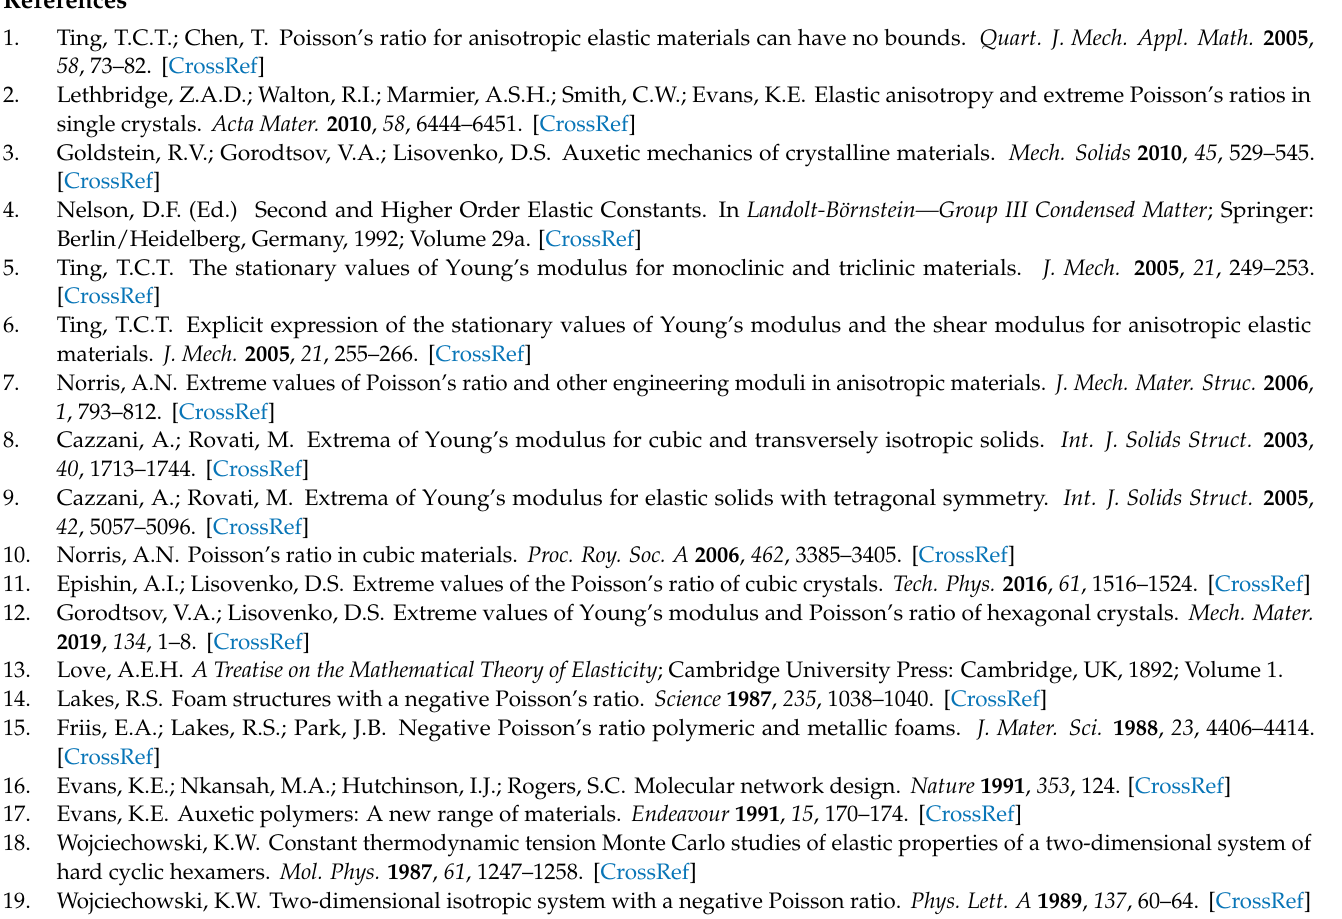
rhombic crystals. Table S2: Values of Young’s modulus, E 1 , E 2 , E 3 , E 4 , E 5 , E 6 and E 7 , for rhombic crystals. Global maximum and minimum values are shown in bold. Angle values are given in degrees. Table S3: The values of the minimum and maximum Young’s moduli E min and E max and their ratios E max / E min ; and the values of the minimum and maximum Poisson’s ratios ν min and ν max